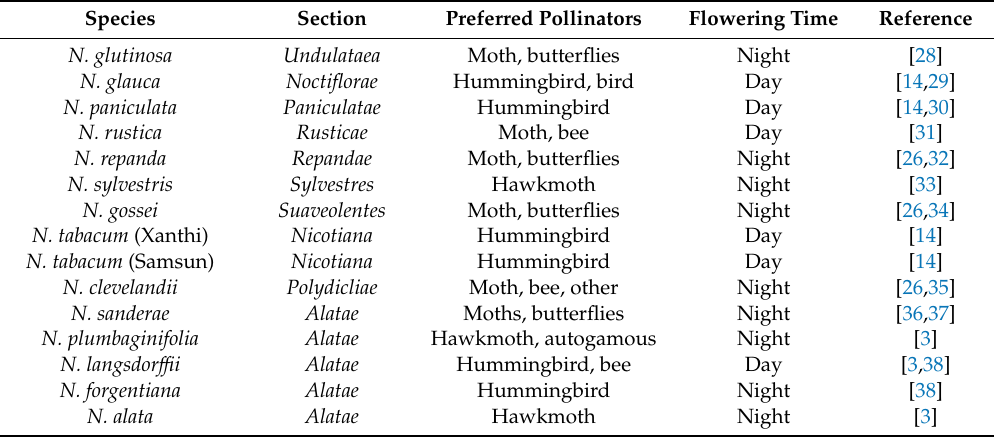
Table 1. Classification and characteristics of Nicotiana species ( N. spp.) studied